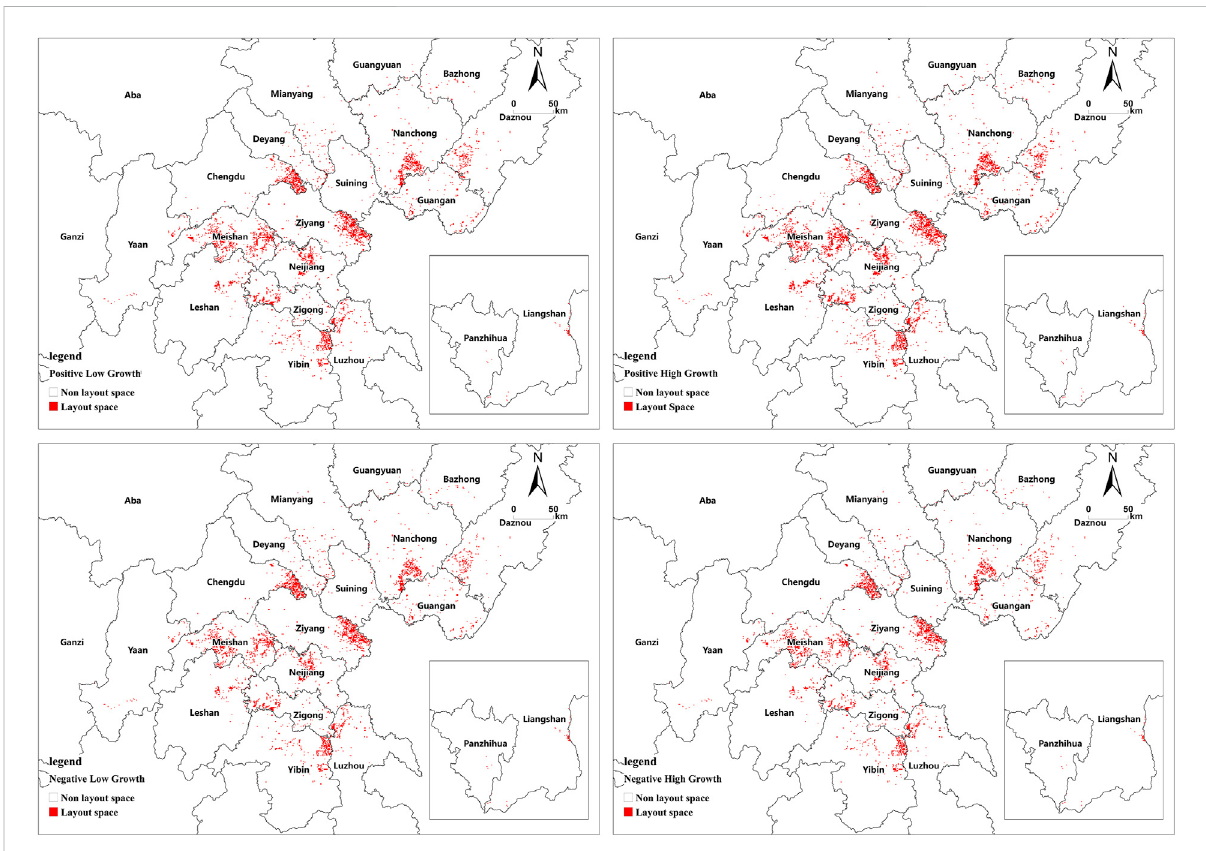
FIGURE 7 Simulation of spatial distribution of citrus production in Sichuan under different